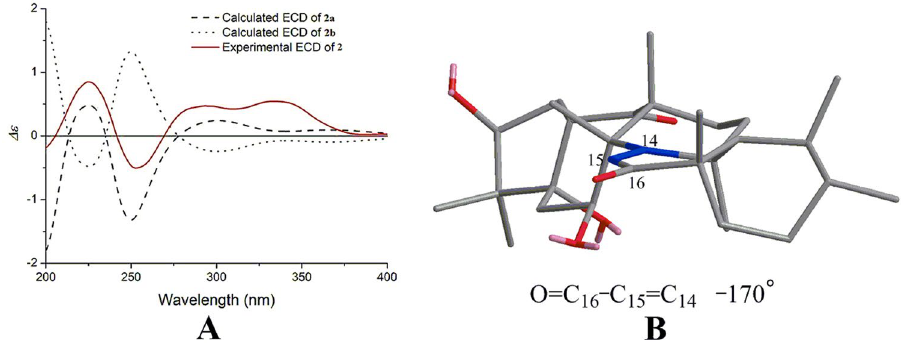
Figure 5. ( A ) Experimental ECD spectrum of 2 , using TDDFT at the B3LYP/6-31 G(d) level in MeOH calculated ECD spectra of 2a and 2b . ( B ) Application for the helicity rule of 2